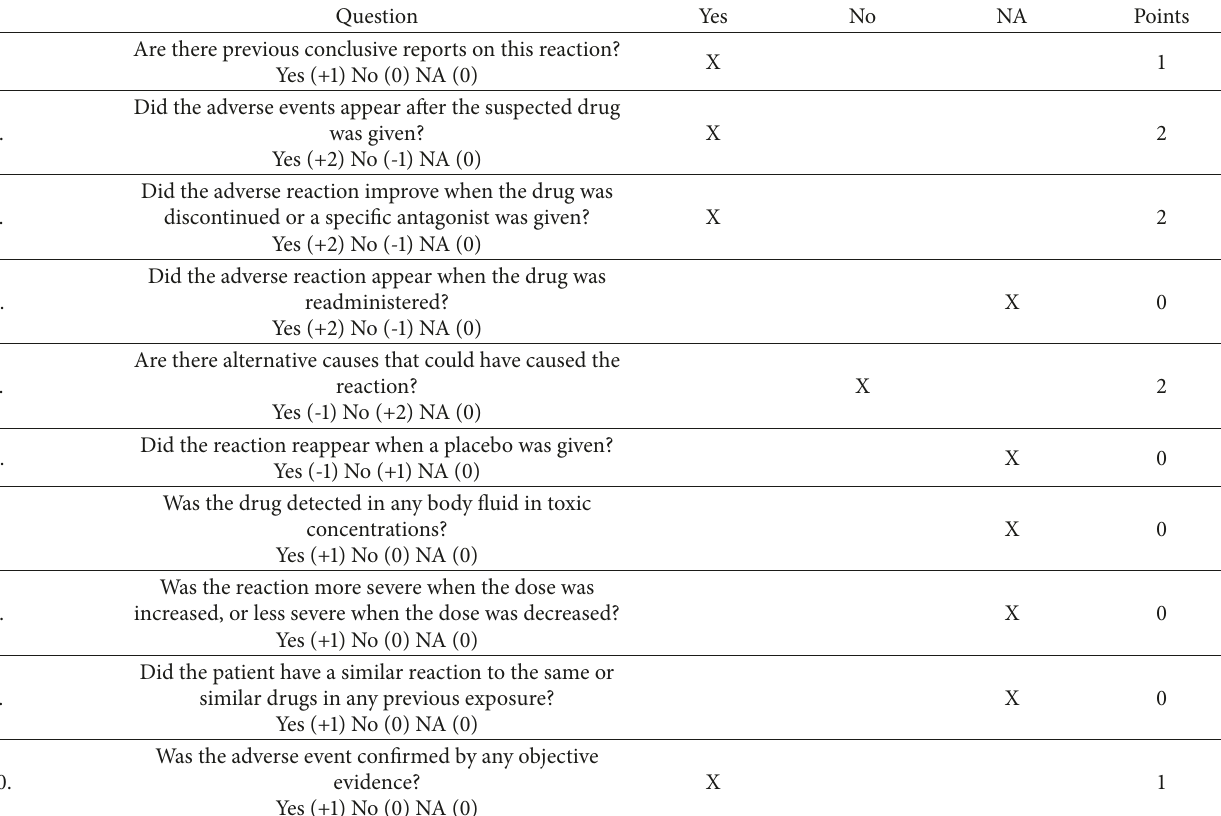
Table 1: Naranjo scoring algorithm for determining possibility of drug reaction, scoring: ≥ 9 = definite ADR, 5-8 = probable ADR, 1-4 = possible ADR, and 0 = doubtful ADR.